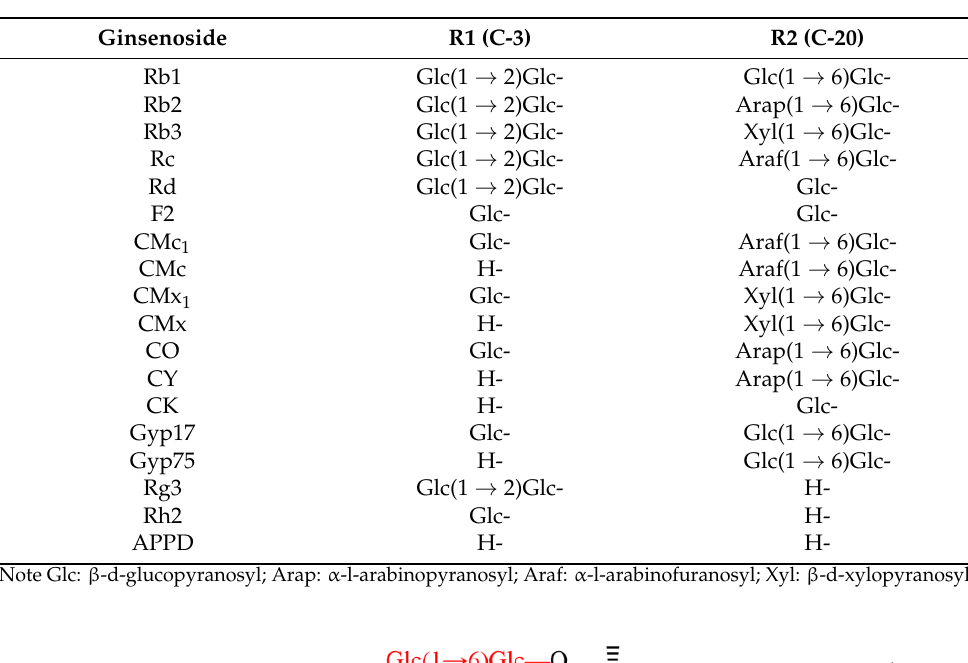
Table 1. Chemical structures of PPD-type ginsenosides.